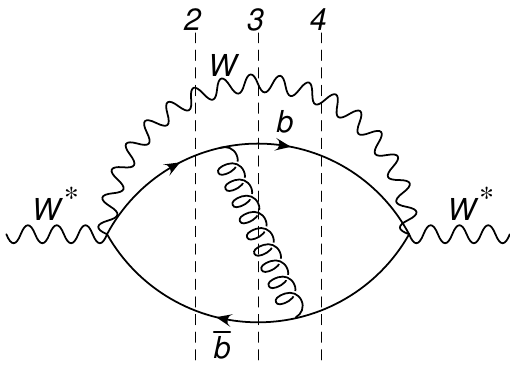
Figure 17 . The reduced graph to look for Landau singularities in the graph of (cid:12)gure